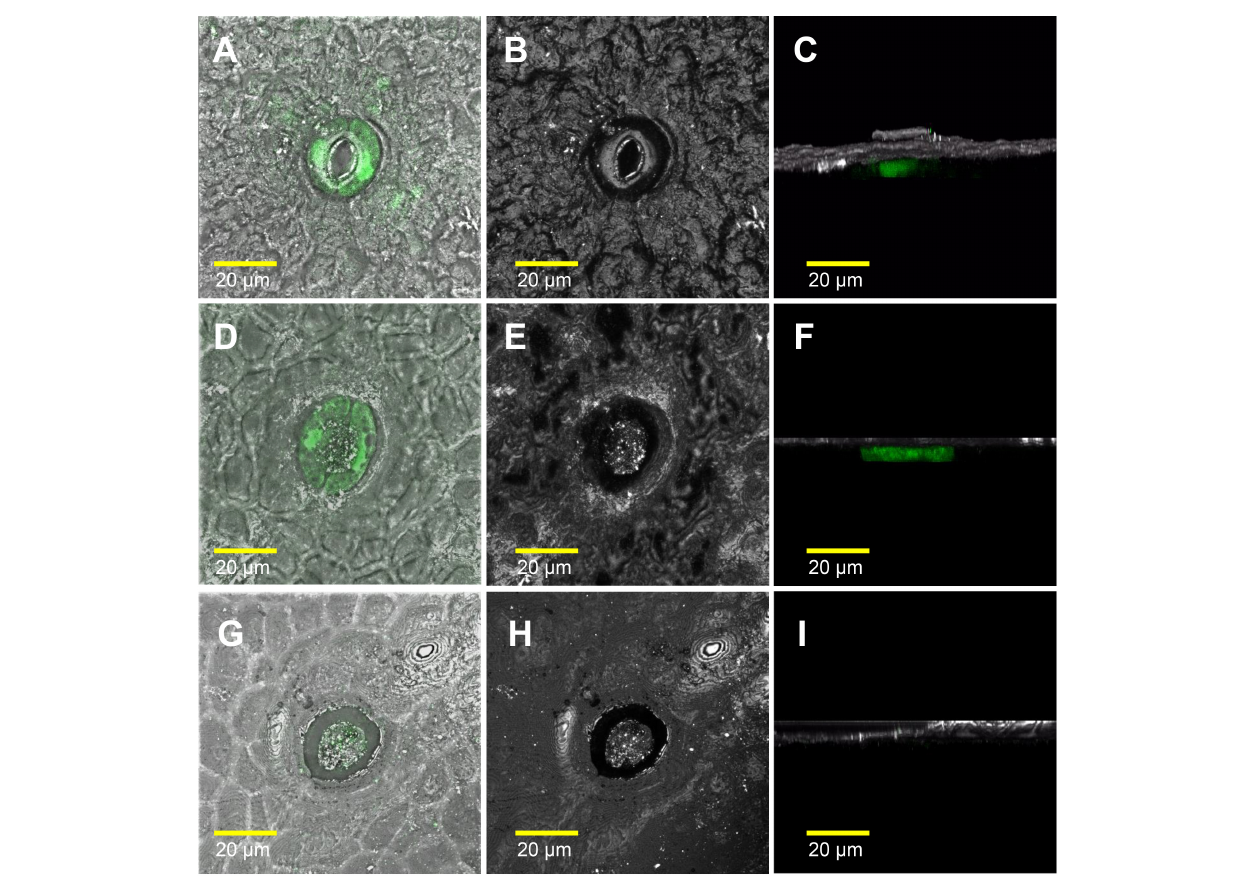
FIGURE 7 | The stomatal pores of ripe yellow fruits are plugged. The confocal images A , D , and G are merged images of white light, reflections of the sample, and GFP fluorescence (stained green). The confocal images B , E , and H are reflections of the sample. The confocal images C , F , and I are 3D simulations, to provide a side view of the stomata, composed of reflections of the sample and GFP fluorescence (stained green). Breaker fruits were harvested from GCGFP plants. (A–C) Stomata were taken from a green segment of the fruit. (D–F) Plugged stomata from a yellow segment of the fruit; GFP staining can still be observed within the guard cells. (G–I) Plugged stomata from a yellow segment of the fruit in which GFP was not detected in the guard cells. Analyses were performed on three biological